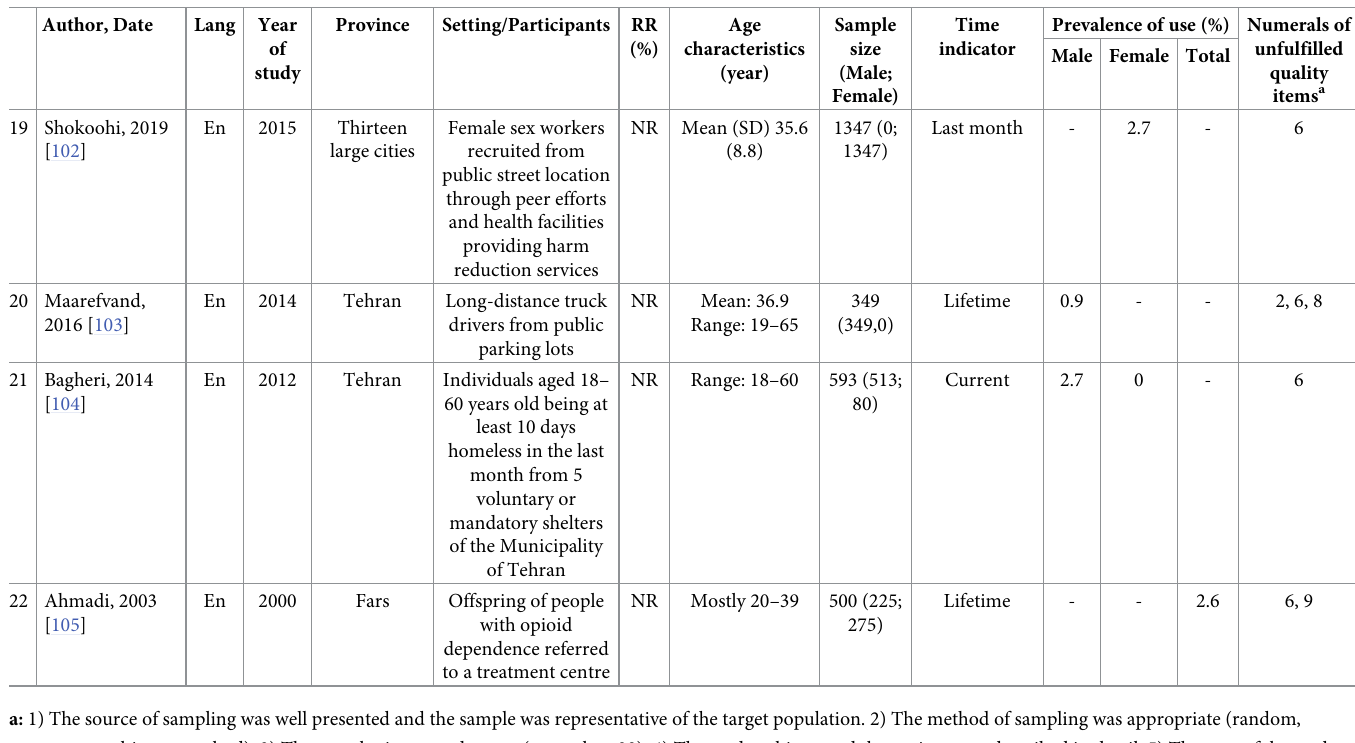
students (Table 5 and S6 Fig). Across all years, 0.4% (95%CI: 0.1–0.7; I 2 = 69.1%; 5 studies)